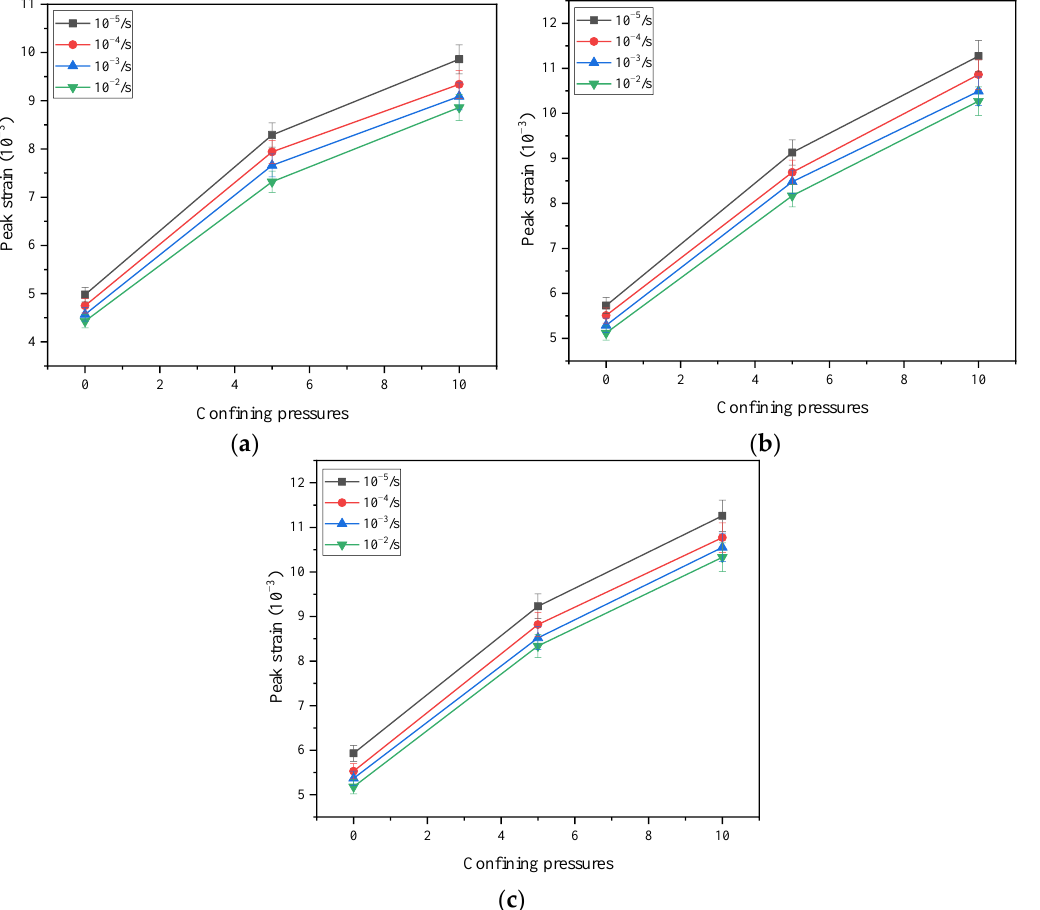
Figure 9. Peak strain of concrete specimens with 100 F–T cycles under different confining pressures. ( a ) SF0. ( b ) SF10. ( c )